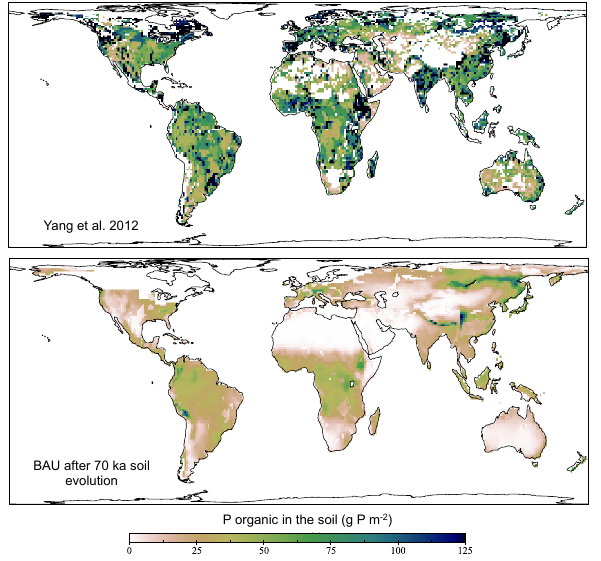
Figure B1. Global maps of P in the litter and soil organic matter in the soils after (upper panel) data replotted from Yang et al. (2013). Lower panel shows a modelling result after 70000yr soil evolution, taking into account the active P uptake mediated by root exudation.